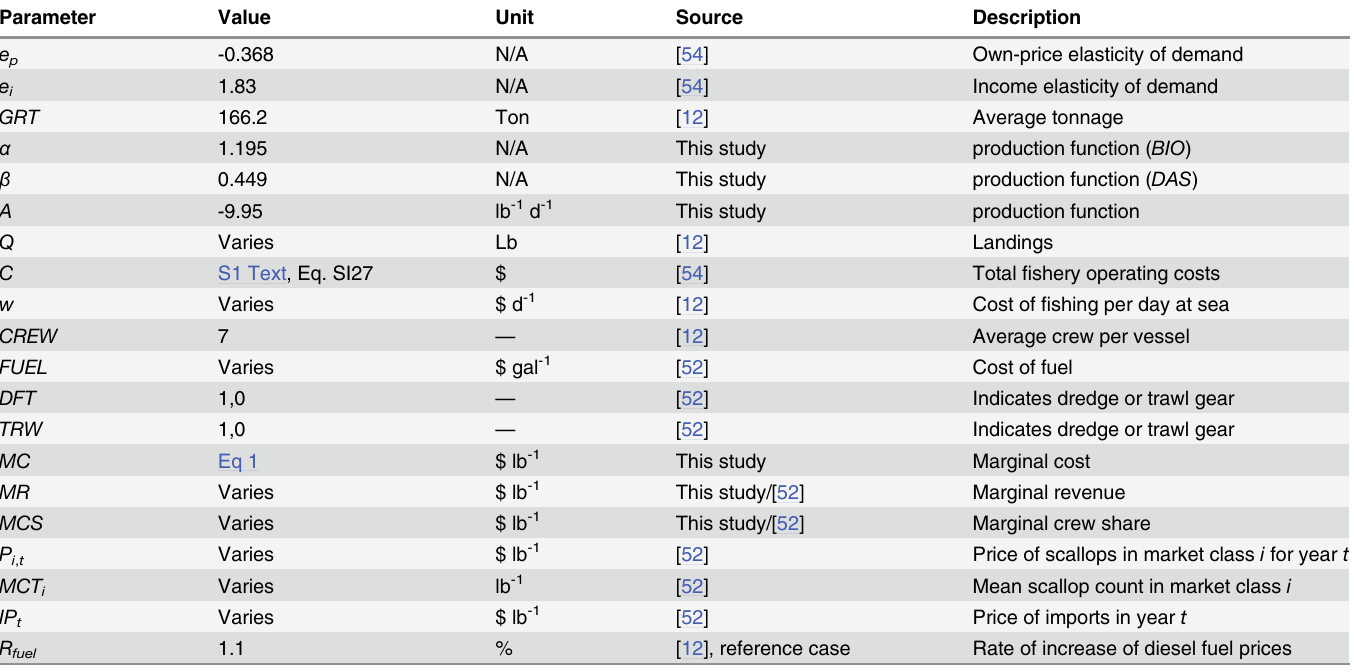
Table 3. Parameters and quantities in the socioeconomic submodel.